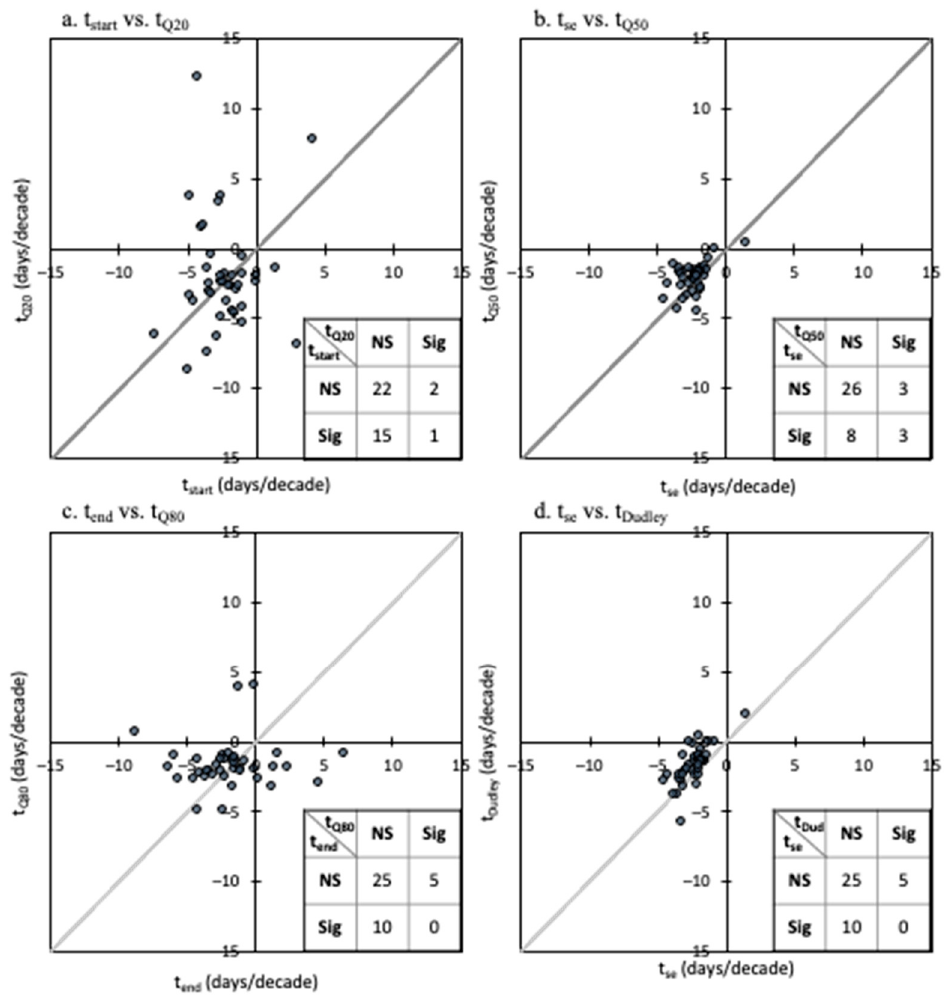
Figure 3. Comparison of the timing metric trends for the ( a ) start, ( b ) half-flow, and ( c ) end of the snowmelt contribution to the streamflow, and ( d ) Dudley. The tables in the bottom right corner indicate the number of stations at which the trends were not significant (NS) and significant (Sig).